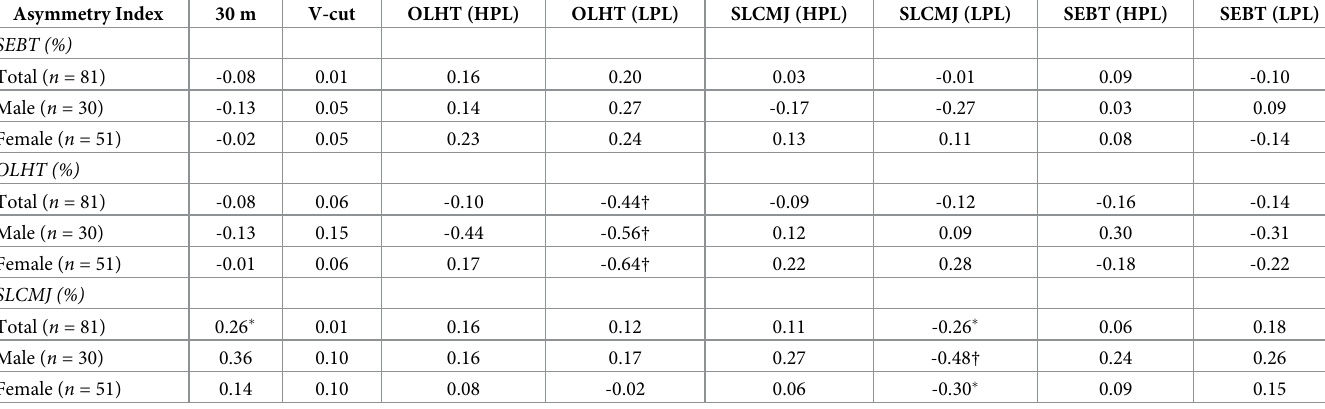
asymetries in male population (Table 2). In addition, mean inter-limb asymmetry values for male and female athletes are shown in Fig 1. The SEBT showed between-limb differences of 15.3 ± 18.8% for males and 11.3 ± 12.9% for females, representing a small ES (0.25). The OLHT showed between-limb differences of 5.92 ± 4.61% for males and 6.03 ± 7.0% for females, representing a trivial ES (0.0). The SLCMJ showed between-limb differences of 12.9 ± 10.4% for males and 10.8 ± 6.92% for females, representing a small ES (0.3). Pearson’s correlations ( r ) between inter-limb asymmetry and test scores are shown in Table 3. Results showed significant ( p < 0.05) but small ( r = 0.26) relationships between SLCMJ asymmetries and 30 m sprint time for the total group. Significant negative correlations with small to moderate magnitude of correlation were also present between SLCMJ asymme- tries and SLCMJ performance on the lowest performing limb for the total group ( p < 0.05; Table 3. Pearson’s correlations ( r ) between inter-limb asymmetry values and performance test scores for the total group and when separated by